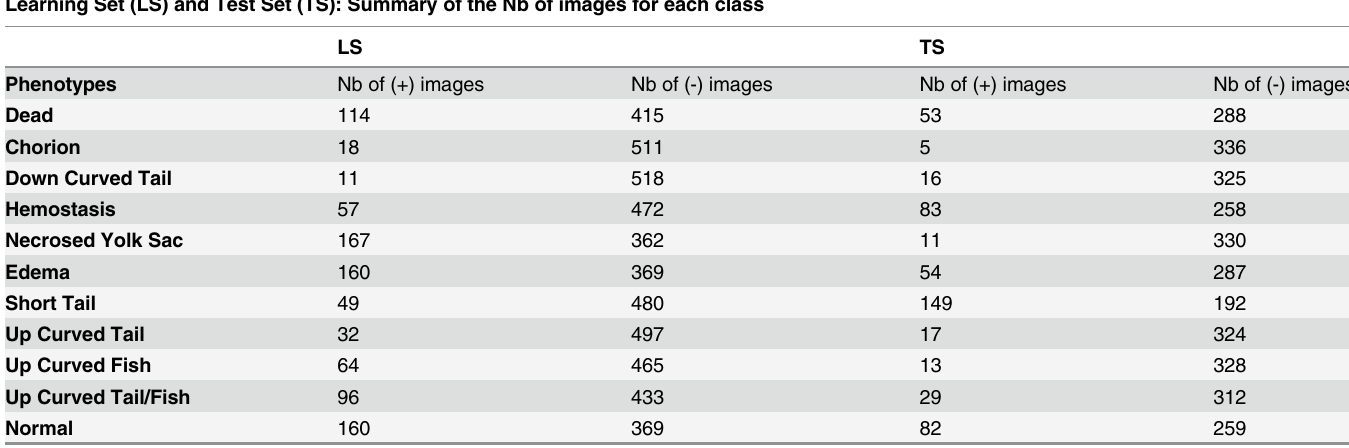
Table 2. Number of images by class (+) and (-) for each phenotype, in the learning set (LS) and the test set (TS). Learning Set (LS) and Test Set (TS): Summary of the Nb of images for each